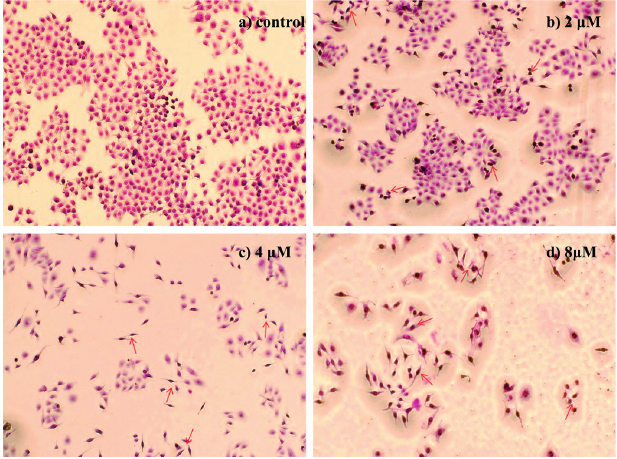
Figure 2. Morphological observation of HepG2 cells using Giemsa staining (200×): ( a ) Control group; ( b ) 2 μ M; ( c ) 4 μ M; and ( d ) 8 μ M. The cell morphology was observed under the light microscope after Giemsa staining. The most representative fields are shown. Arrows indicate the typical apoptotic